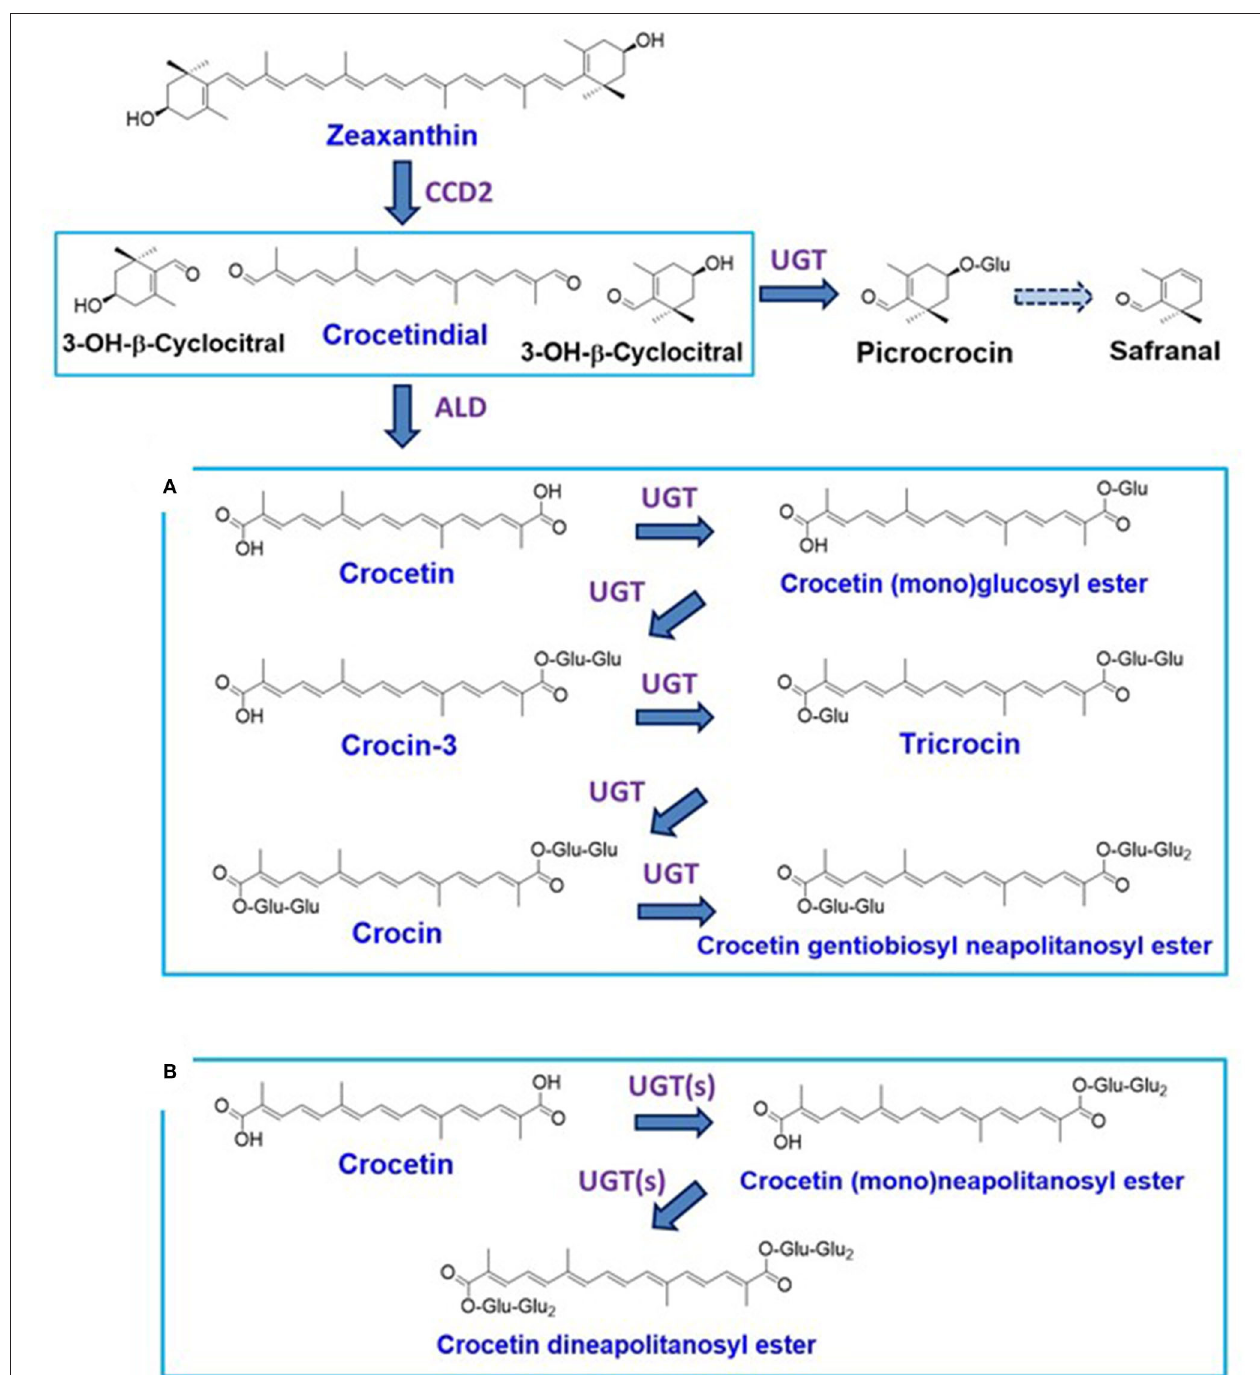
FIGURE 1 | Carotenoid metabolism in saffron [stigmas of Crocus sativus ; (A) ] and the yellow flowers of freesia [ Freesia x hybrida ; (B) ].